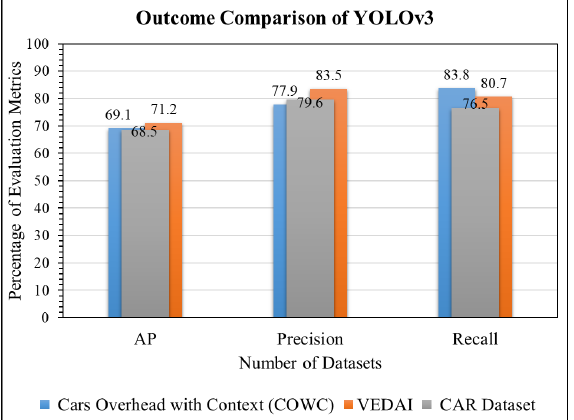
Figure 9. Result of YOLOv3 approach on different